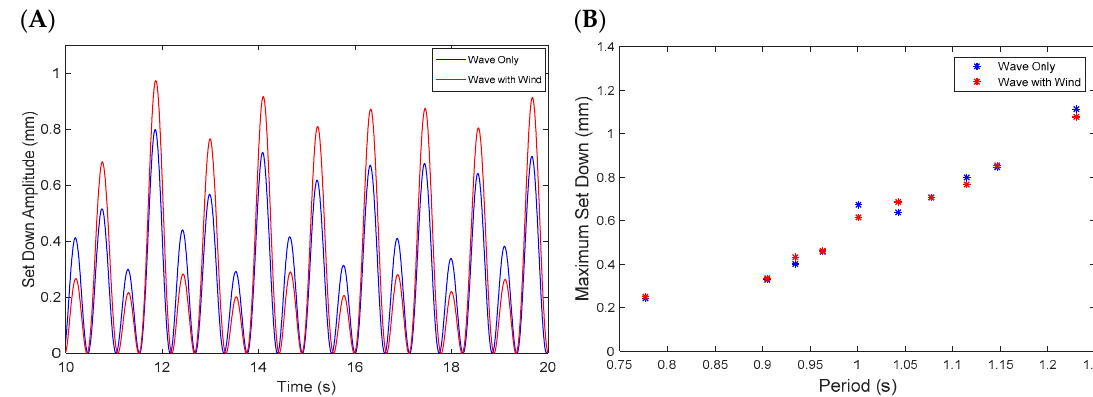
Figure 16. Comparison of set-down time history for condition 3 ( A ) and maximum set-down experienced for all conditions ( B ).